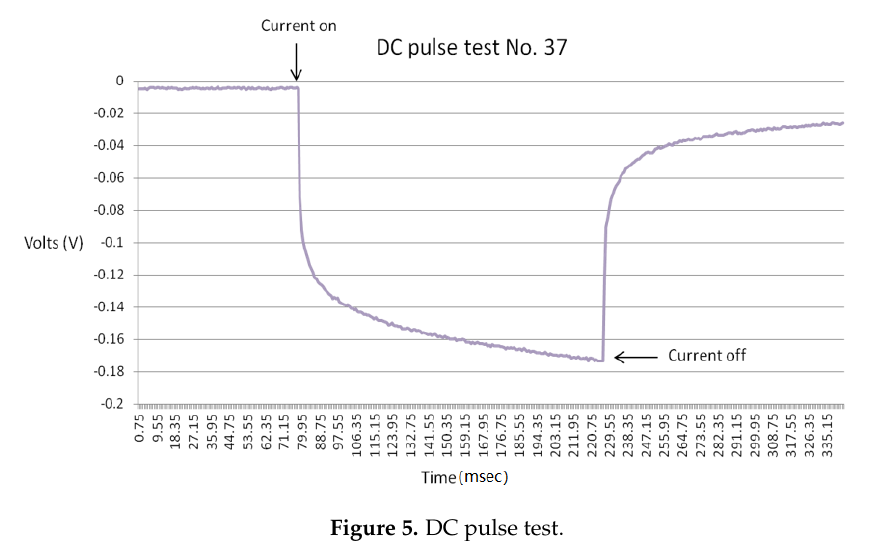
Figure 5. DC pulse test.